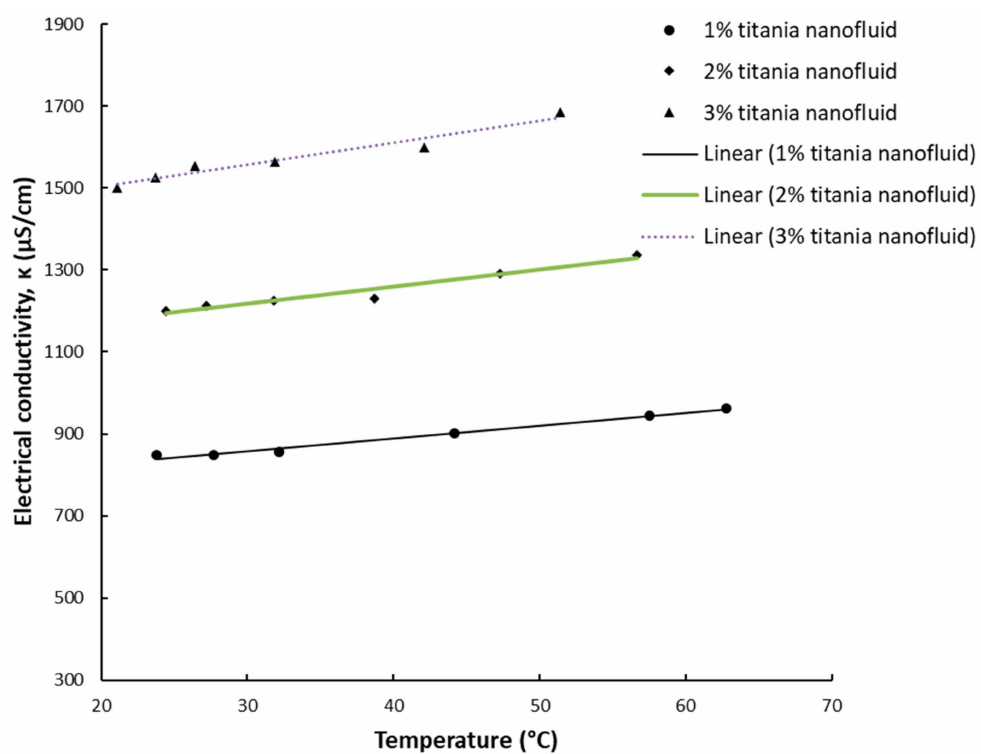
Figure 4. Experimental results on titania nanofluid electrical conductivity variation with temperature.